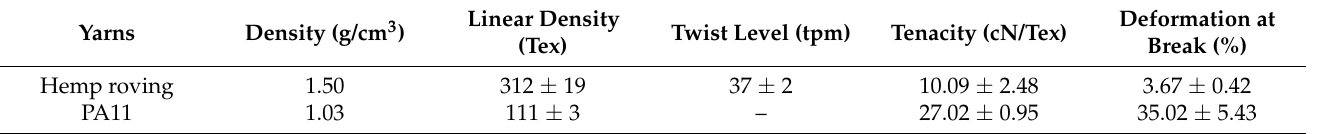
Table 1. The main properties of the raw